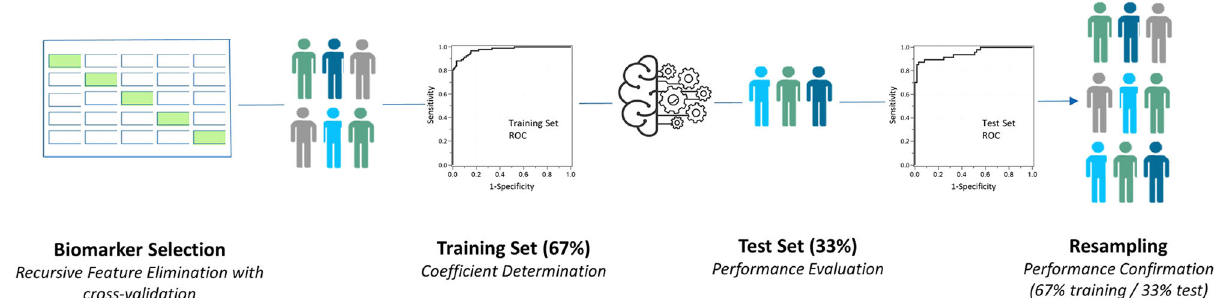
Fig. 2 Development of classi fi cation algorithm for multi-cancer early detection. Biomarker selection is performed via recursive feature elimination (RFE) with cross validation. After the biomarkers are selected, the dataset is split into training and test sets. The training set is used for the determination of the coef fi cients in the logistic regression for each biomarker and the test set is used to evaluate the performance of the logistic regression fi t from the training set in a held-out test set. Finally, the process of splitting the dataset into training and test sets is randomly repeated 100 times for performance con fi